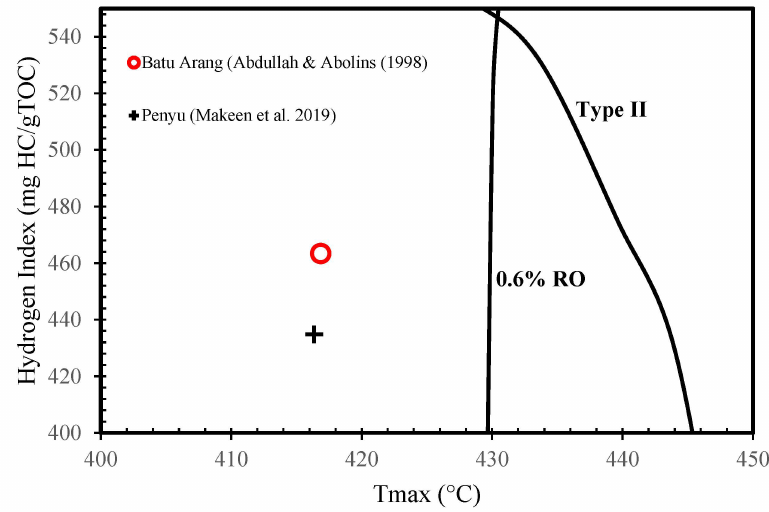
Figure 6. Tmax vs. HI plot showing the type of kerogen in PM.